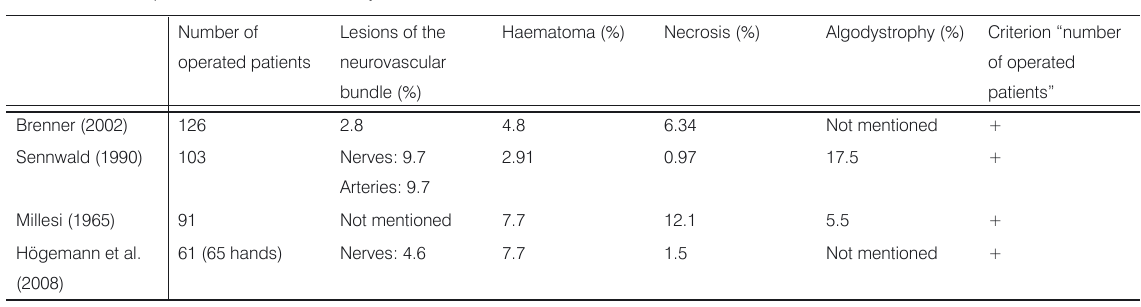
Table 4. Complications of total fasciectomy.